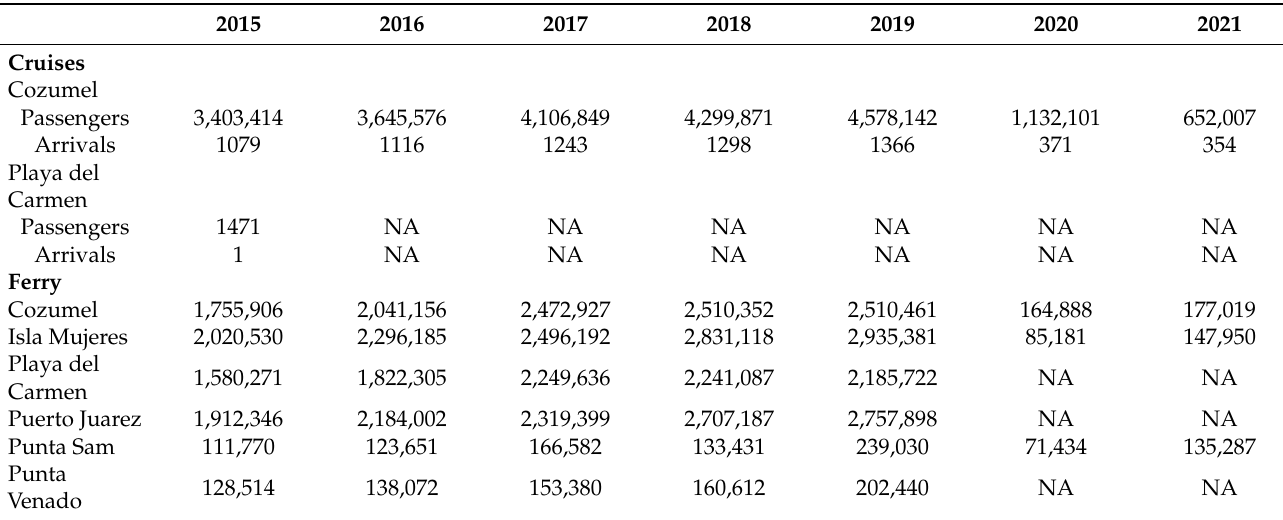
Figure 8. Urban infrastructure. Table 5. Maritime passenger